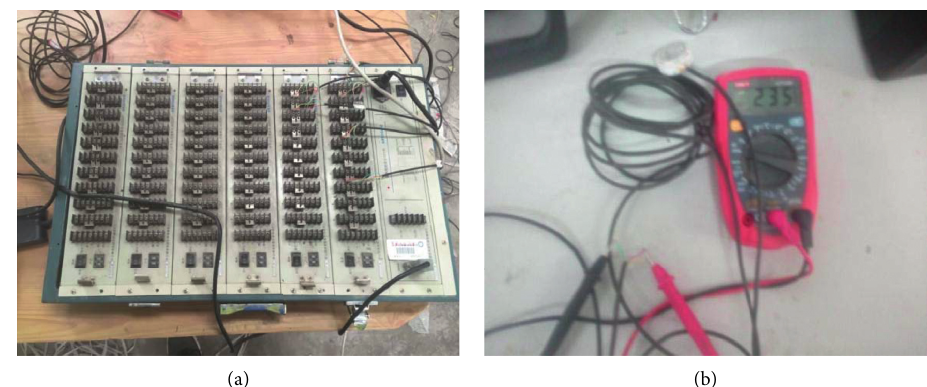
Figure 3: Pictures of (a) YE2539 high-speed static strain gauge and (b) pressure cell.